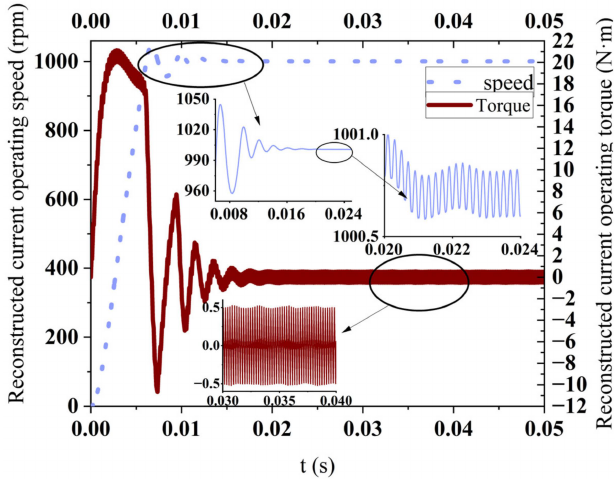
Figure 6. The steady-state operating conditions of the reconstructed current.